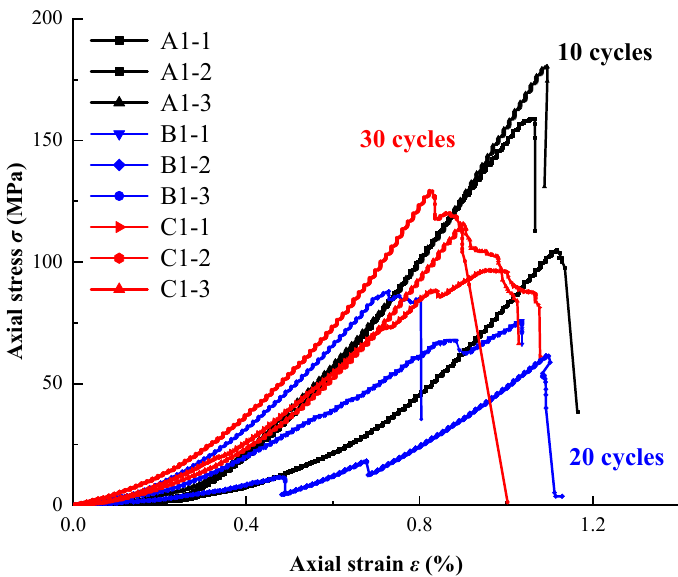
Figure 6. Axial stress–strain curves of pre-damaged specimens with σ 3 = 50 MPa.